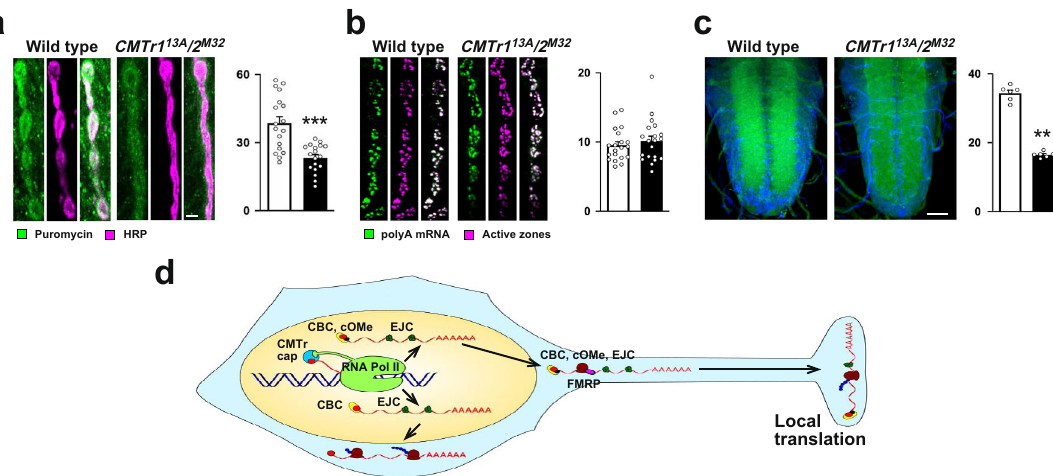
Fig. 6 2 ‘ - O -ribose methylation of mRNA cap-adjacent nucleotides enhances translation at synapses. a Staining of synapses at third instar NMJs with anti-puromycin antibodies (left, green) and with anti-HRP recognizing a neuronal epitope (right, red) after 30 min of puromycin incorporation in control and CMTr1 13A ; CMTr2 M32 double mutant larvae. The mean ± SE of the intensity is shown on the right is arbitrary units in white for the control, in black for CMTr1 13A ; CMTr2 M32 double mutant larvae ( n = 18, *** p ≤ 0.001). b RNA in situ hybridization with an oligo(dT) probe to mRNA in synapses at third instar NMJs (left, green) in control and CMTr1 13A ; CMTr2 M32 double mutant larvae. The active zone of synapses was stained with nc82 (magenta, right). The mean ± SE of the intensity is shown on the right is arbitrary units in white for the control, in black for CMTr1 13A ; CMTr2 M32 double mutant larvae ( n = 20). c RNA in situ hybridization with an oligo(dT) probe (green) to mRNA in the ventral nerve cord of third instar larvae (green) in control and CMTr1 13A ; CMTr2 M32 double mutant larvae counterstained with DAPI (blue). The mean ± SE of the intensity is shown on the right is arbitrary units in white for the control, in black for CMTr1 13A ; CMTr2 M32 double mutant larvae ( n = 6, ** p = 0.002). Scale bars in a and c are 1 µ m and 50 µ m, respectively. Statistical analysis was done by an unpaired t -test. d Model for the role of cap-adjacent 2 ′ - O -ribose methylation in gene expression in neurons. EJC exon junction complex containing Y14 and eIF4AIII, CBC cap-binding complex consisting of CBP20 and 80, CMTr cap methyltransferase, FMRP Fragile X Mental Retardation Protein, cOMe cap 2 ′ -O-ribose methylation at cap-adjacent nucleotides, ribosomes are shown as brown blobs. Source data for the intensity of pre-synaptic bouton and brain stainings are provided as a Source Data fi